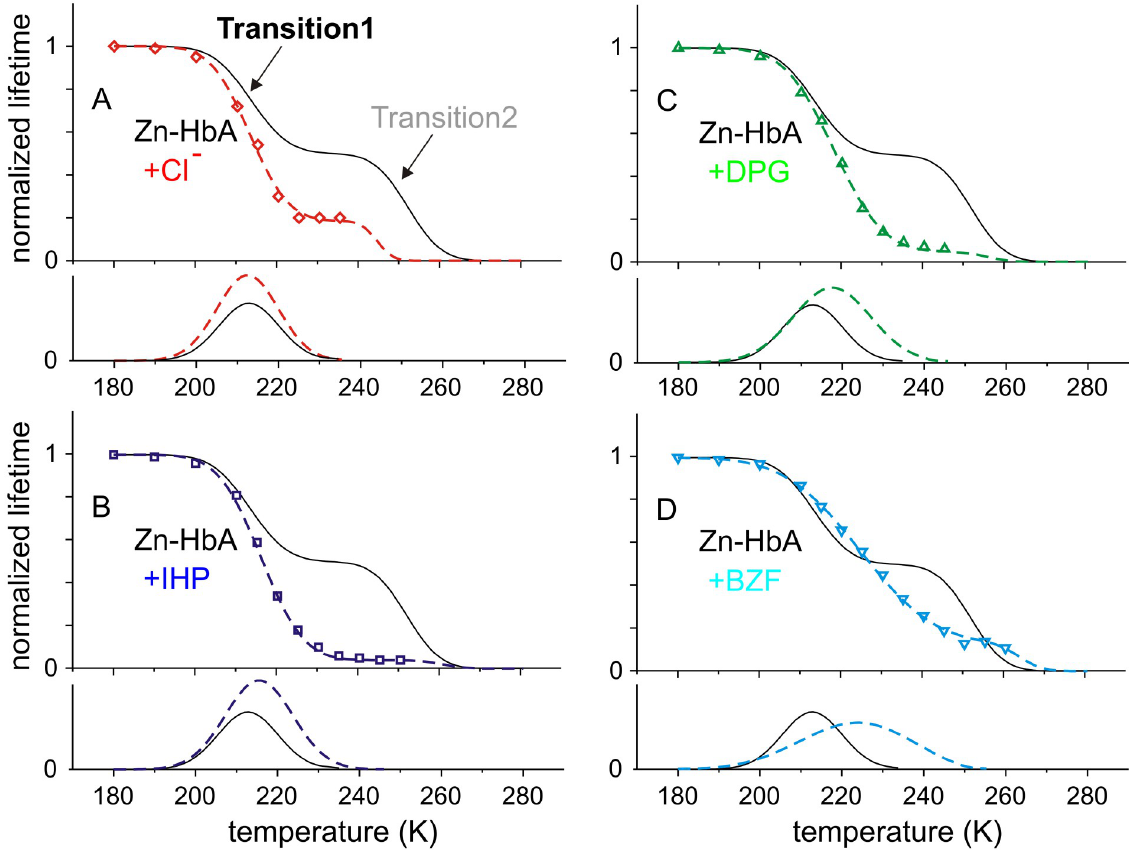
Fig 3. Normalized average phosphorescence lifetime values of Zn-HbA bound to different allosteric effectors as a function of temperature. Original data points are shown with symbols. Transition1 is marked with colors. The original, colored dashed curves are the fitting functions of the thermodynamic model: Zn-HbA bound to Cl - : red diamonds (A); to IHP: blue squares (B); to DPG: green upward triangles (C); to BZF: cyan downward triangles (D). For comparison, the Transition1 of stripped Zn-HbA is also shown in each graph with black curve, but Transition2 on it is marked with gray dashed curve. The negative derivative functions are also shown just below the presented dataset (bottom graphs).